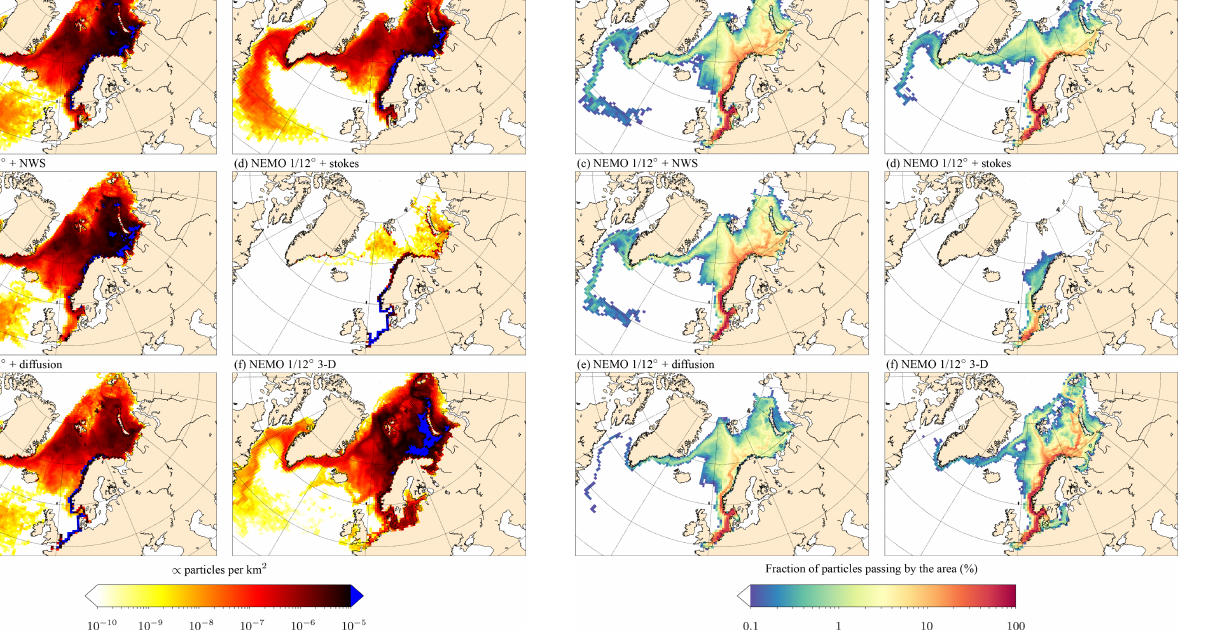
Figure 6. Density of floating microplastic (a–e) and passive 3-D particles (f) , averaged over the third year of particle age, for the different simulation scenarios: (a) NEMO 1 / 12 ◦ , (b) NEMO 1 / 4 ◦ , (c) NWS nested into NEMO 1 / 12 ◦ , (d) NEMO 1 / 12 ◦ coupled with Stokes drift from WaveWatch III, (e) NEMO 1 / 12 ◦ coupled with diffusion, (f) NEMO 1 / 12 ◦ 3-D. Note the logarithmic scale.